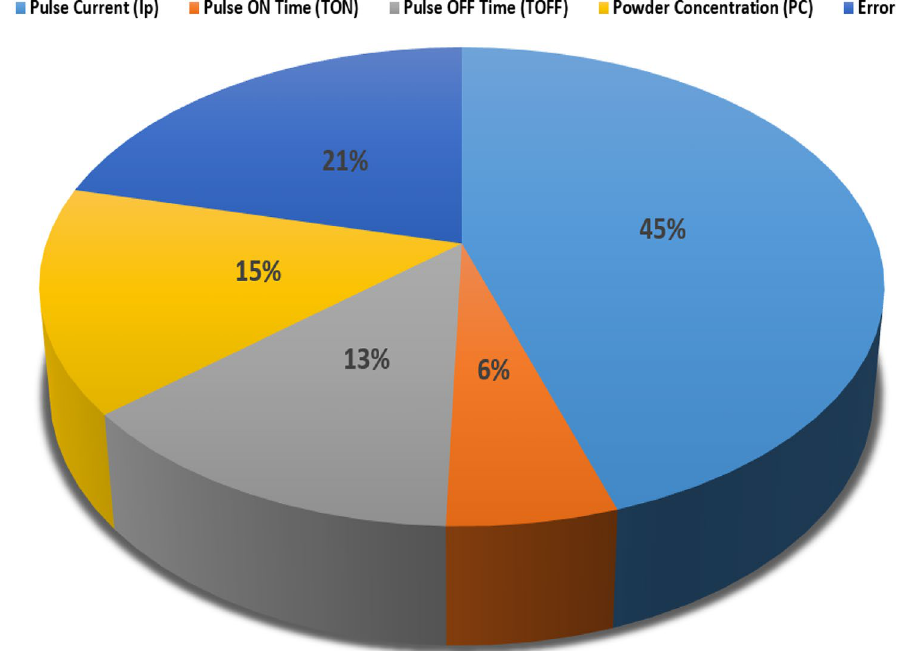
Fig. 4 % Contribution—pro- cess